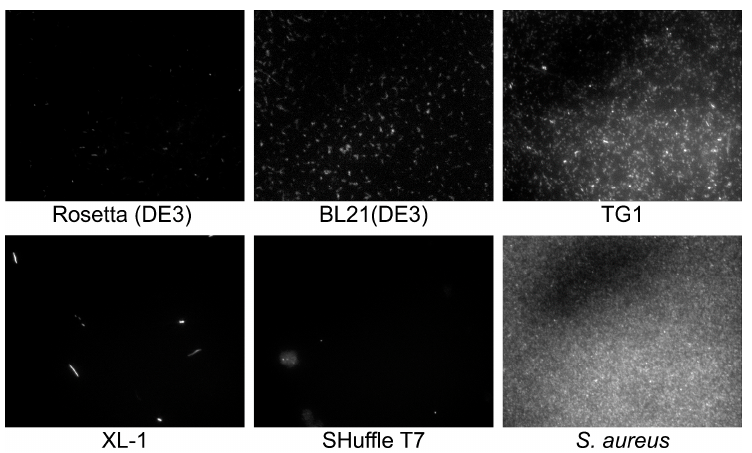
Figure 2. Cell morphology of different E. coli strains visualized by fluorescence microscopy. GFP- producing reporter S. aureus cells were used as a control. BL21(DE3) and TG1 strains of E. coli were suitable as a template for the creation of live biosensors since they provided homogeneous cell cultures with a high level of cell fluorescence. Other strains were inappropriate as a reporter. Rosetta (DE3) had a mediocre fluorescence. Xl-1 had a stretched morphology with a high number of odd rod cells. SHuf- fle T7 formed cell aggregates. Further, E. coli BL21(DE3) was used for live biosensors’ en- gineering.